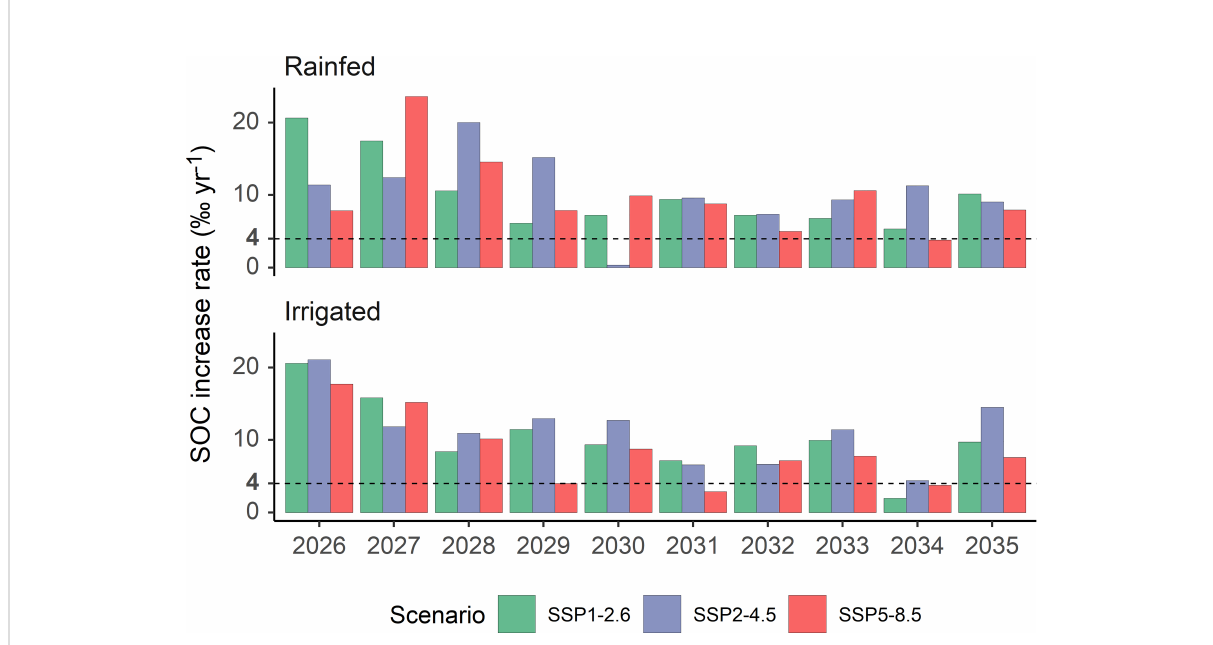
FIGURE 9 DNDC-simulated increase rate ( ‰ yr -1 ) of soil organic carbon of marginal land with sown alfalfa pastures in northern China from 2026 to 2035 under three IPCC SSP scenarios. The dashed horizontal line represents the increase rate advocated by the “ 4 per Mille ” initiative (Minasny et al.,